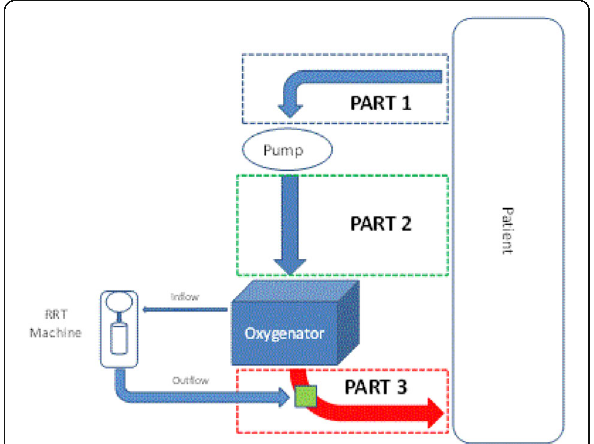
Fig. 1 (abstract 0296). RRT on ECMO according to our protocole